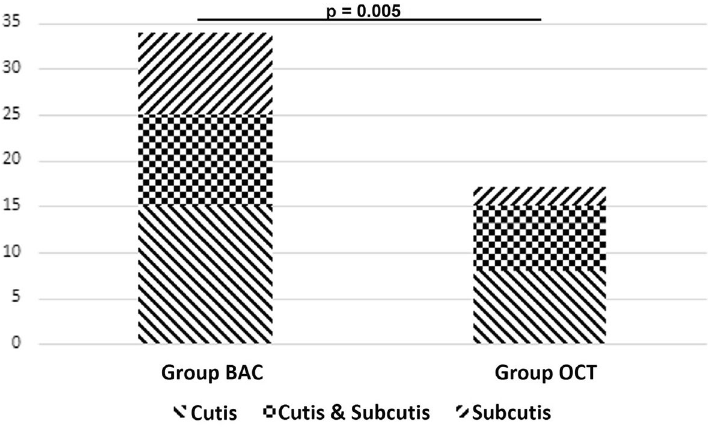
Figure 3. Bacteria detection in different skin layers.